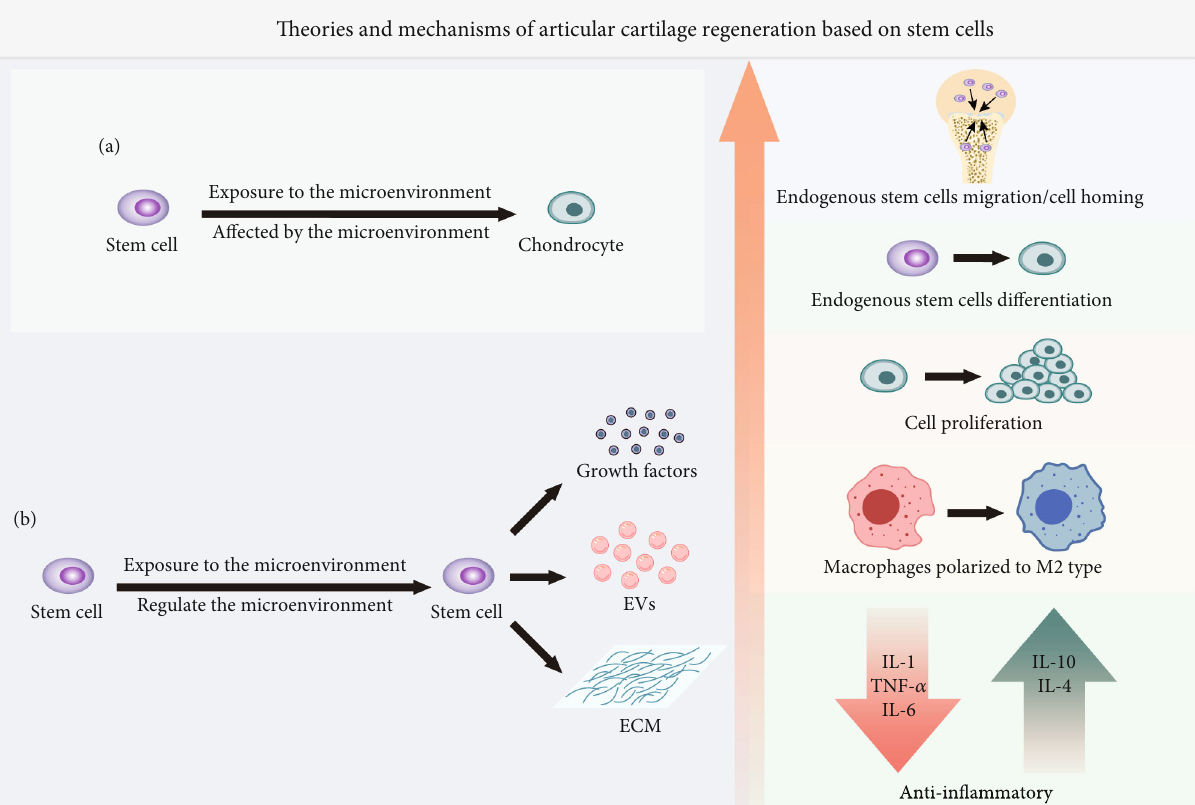
Figure 1: Two theories of articular cartilage regeneration involving stem cells. (a) Stem cell di ff erentiation theory. Stem cells are a ff ected by the microenvironment and directly di ff erentiate into chondrocytes. (b) Paracrine theory of stem cells. Stem cells are a ff ected by the microenvironment and secrete various derivatives, including growth factors, EVs, and ECM. These derivatives have been proven to induce homing of endogenous stem cells, promote the di ff erentiation of endogenous stem cells into chondrocytes, promote the proliferation of chondrocytes, induce macrophages to polarize to the M2 type, and regulate the level of in fl ammatory factors to exert anti-in fl ammatory e ff ects. EVs: extracellular vesicles; ECM: extracellular